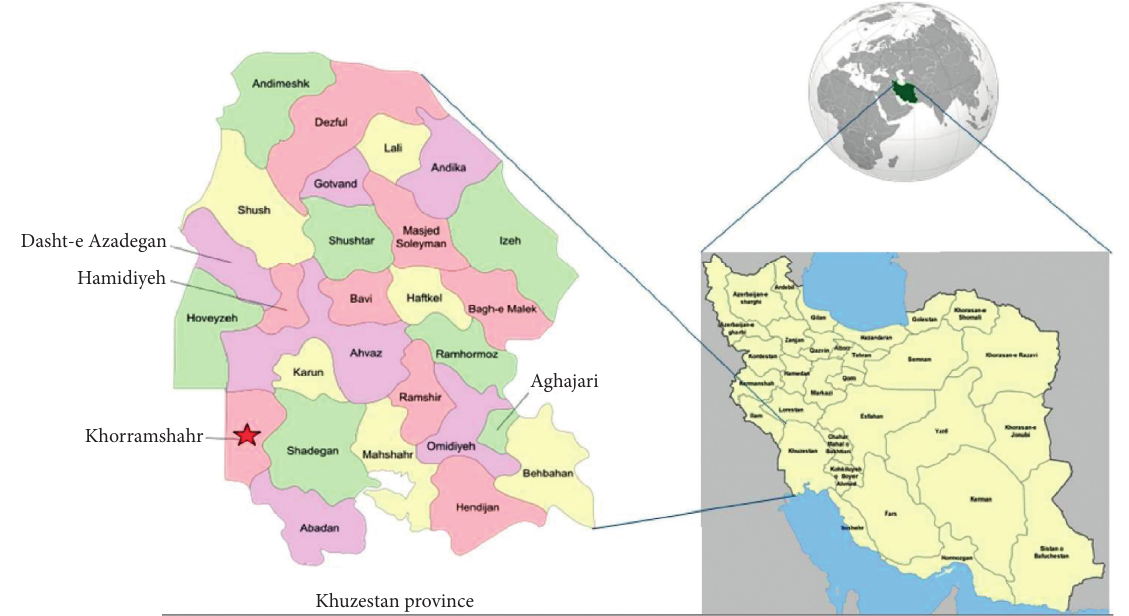
Figure 1: Location of Khorramshahr city. The study region is shown with red Table 1: Demographic characteristics and risk factors related to the seroprevalence of T. gondii infection in T1DM patients, Khorramshahr city.